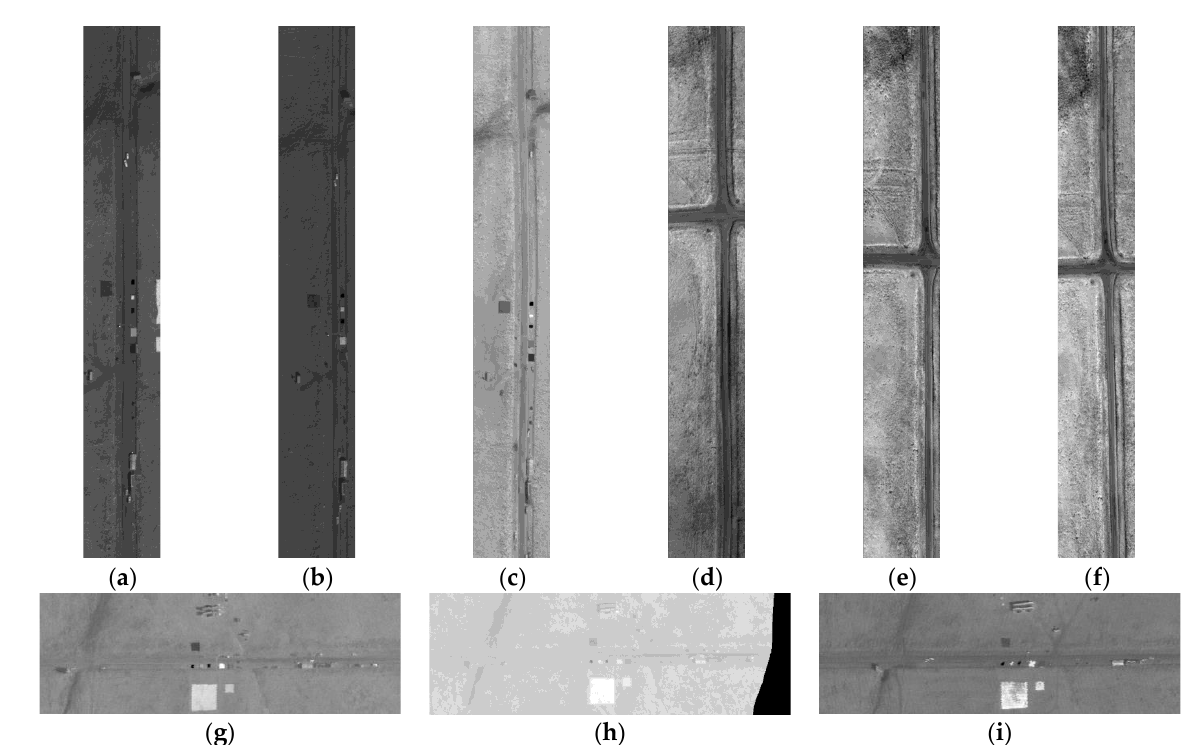
Figure 1. Selected experimental dataset. Sample bands around 7.5 µ m for SEBASS and 8 µ m for TASI are used for illustration. ( a ) LWIR1 a , ( b ) LWIR1 b , ( c ) LWIR1 c , ( d ) LWIR2 a , ( e ) LWIR2 b , ( f ) LWIR2 c , ( g ) LWIR3 a ( h ) LWIR3 b , ( i ) LWIR3 c . The information for the images is provided in Table 3. Table 3. Abbreviations and other characteristics of the selected hyperspectral data set for the regis- tration experiments.